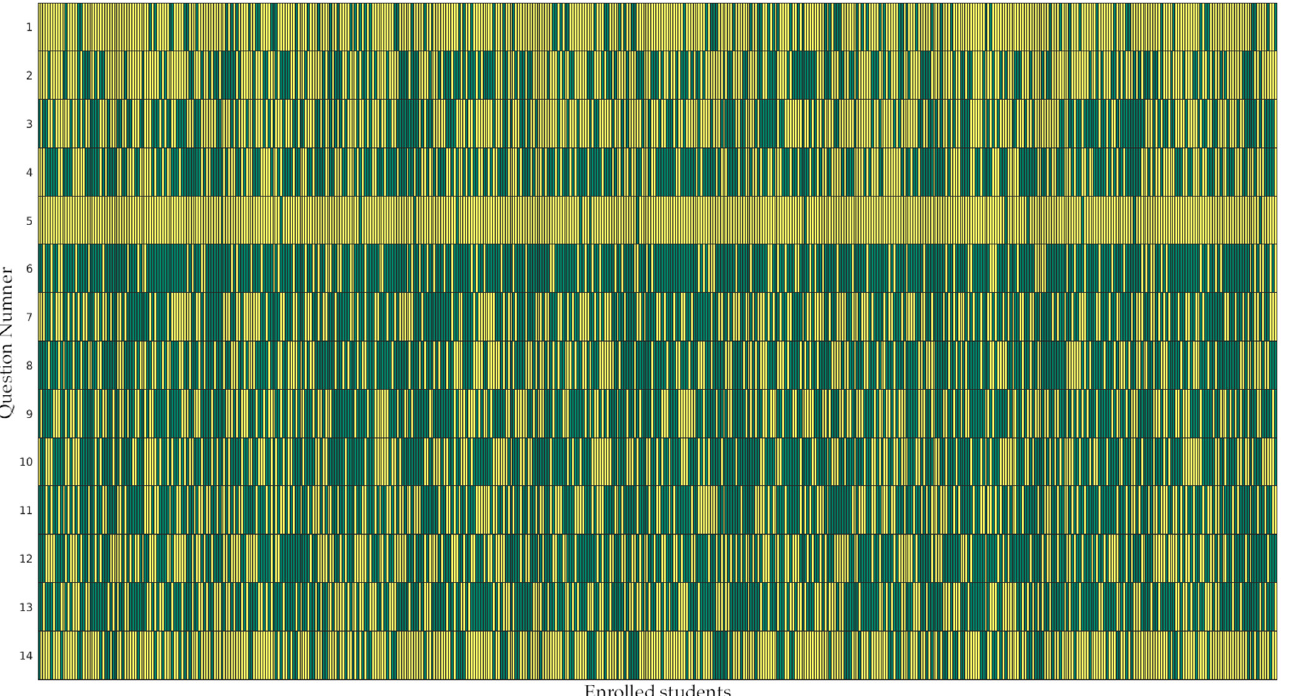
“YES” is represented in yellow. is represented in yellow.